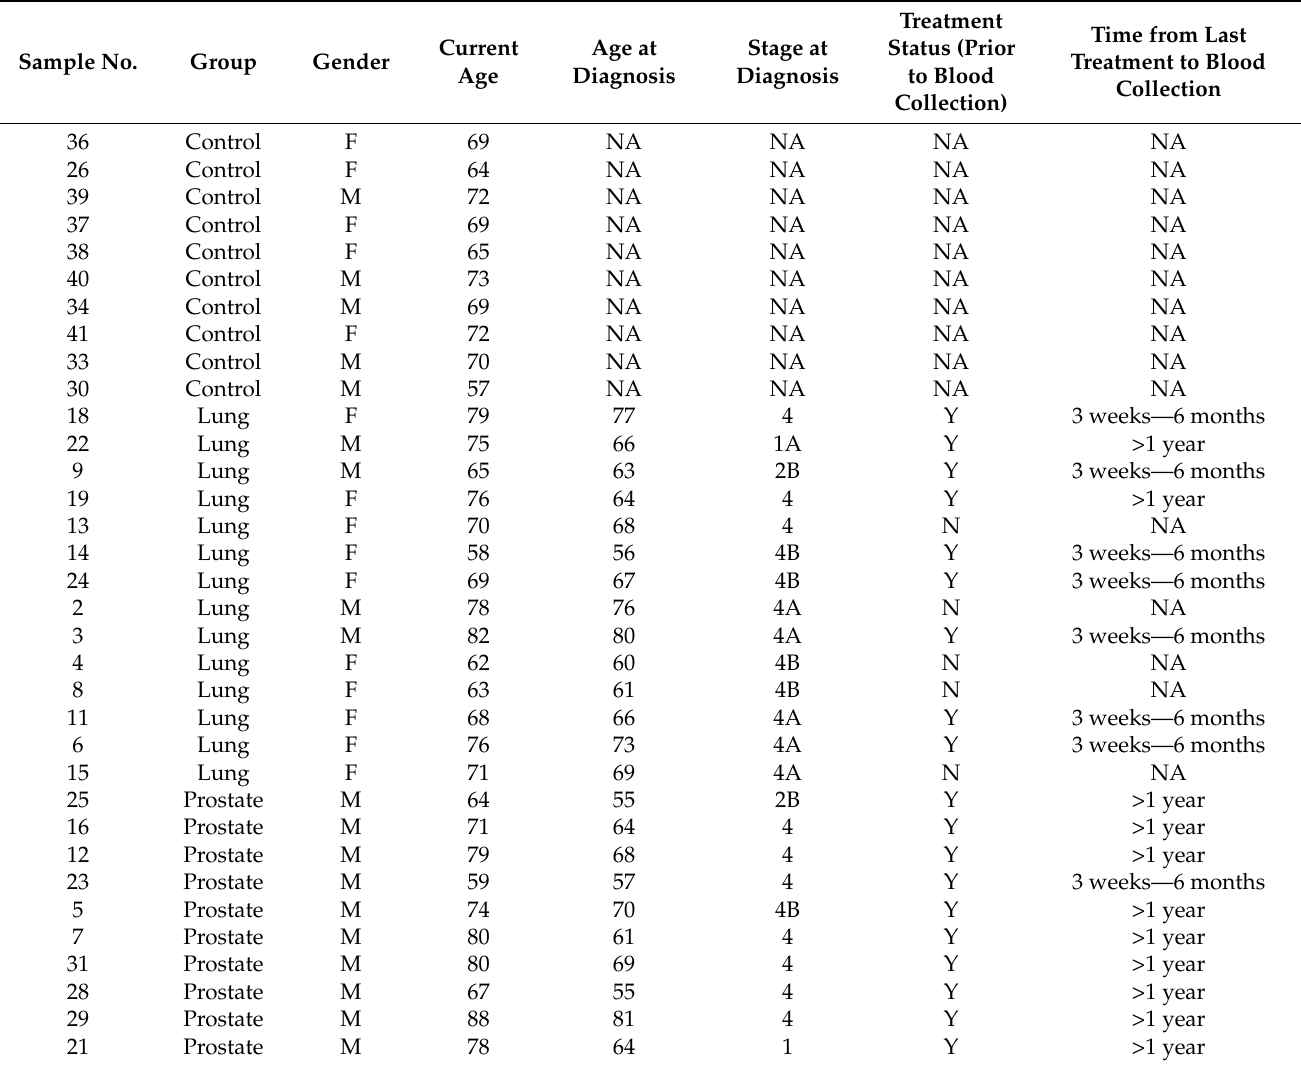
Table 5. Clinical characteristics of patients and healthy